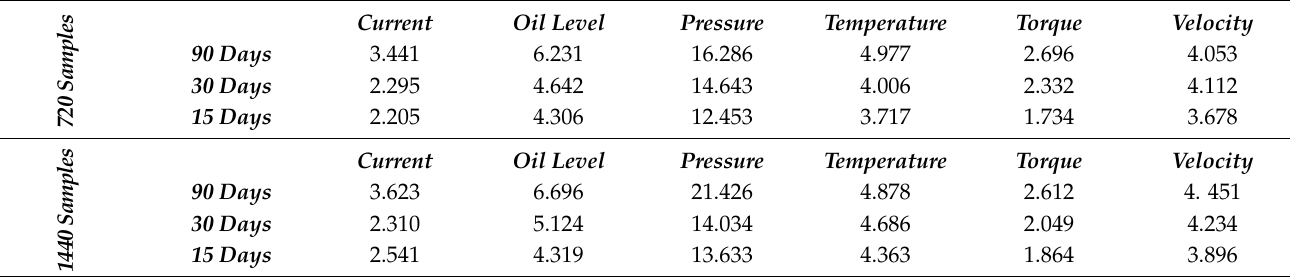
Table 1. Comparative MAPE (%) results.